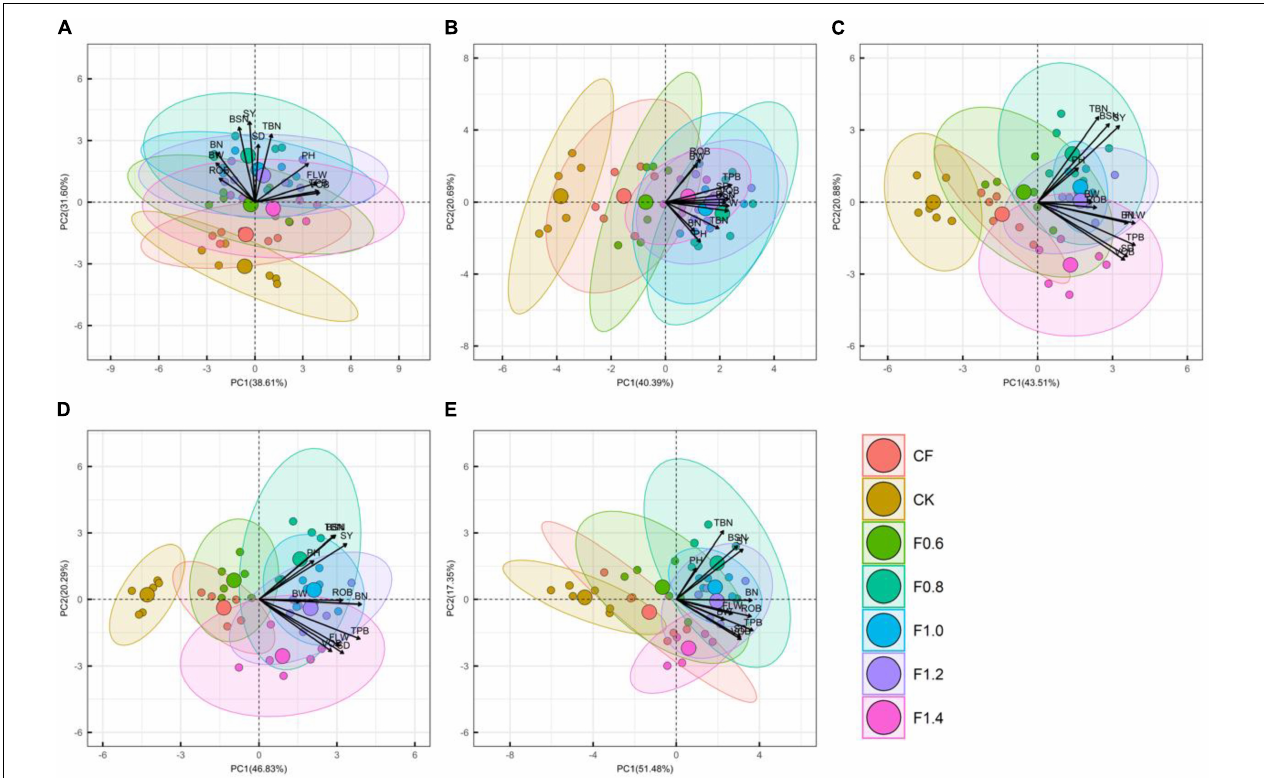
FIGURE 6 | The principal component analysis among measured parameters (i.e., BN, BW, BSN, FLW, PH, ROB, SD, SY, TBN, TPB, and VOB) in different growth stages. The different capital letters in the picture represent different periods of fertility. (A) Full squaring stage, (B) full flowering stage, (C) full boll stage, (D) later full boll stage, and (E) boll opening